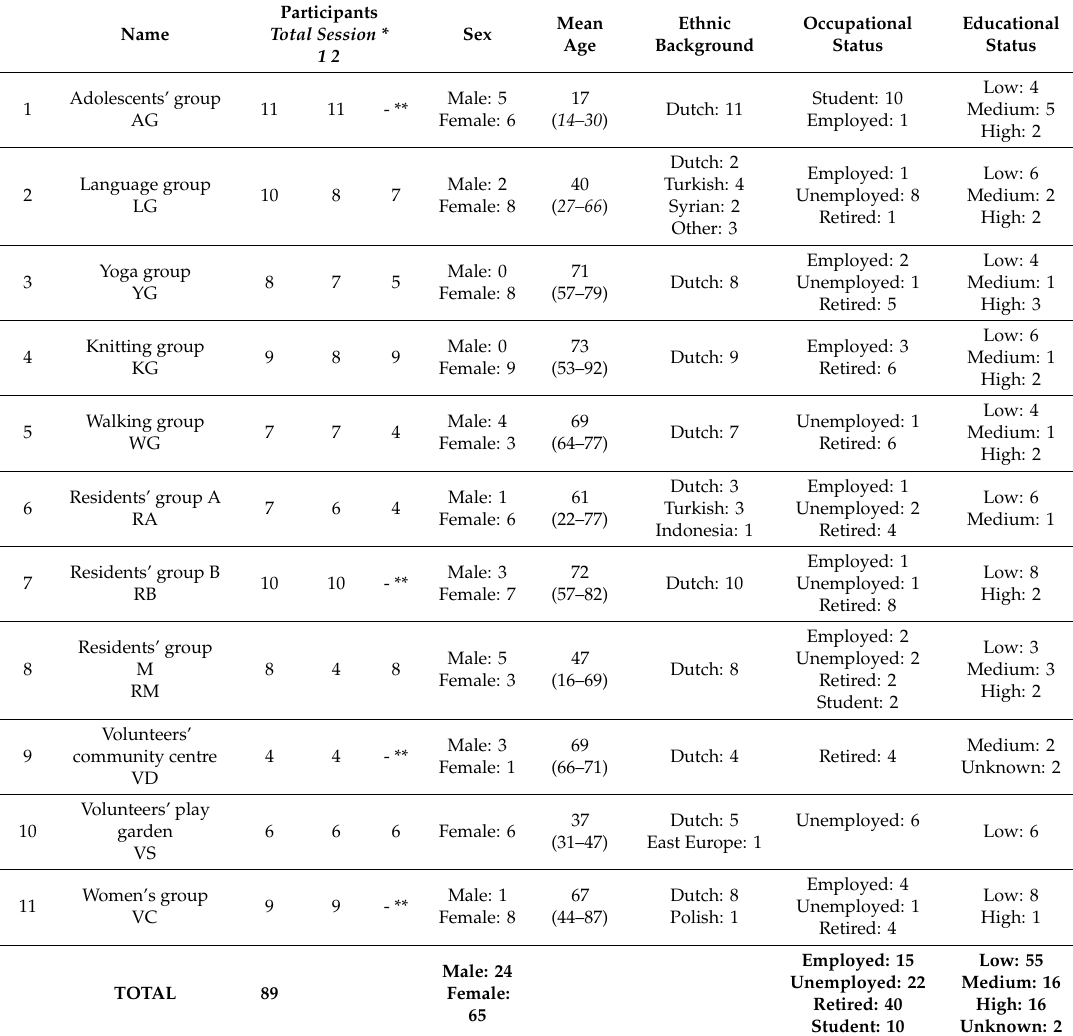
Table 1. Characteristics of the community groups and